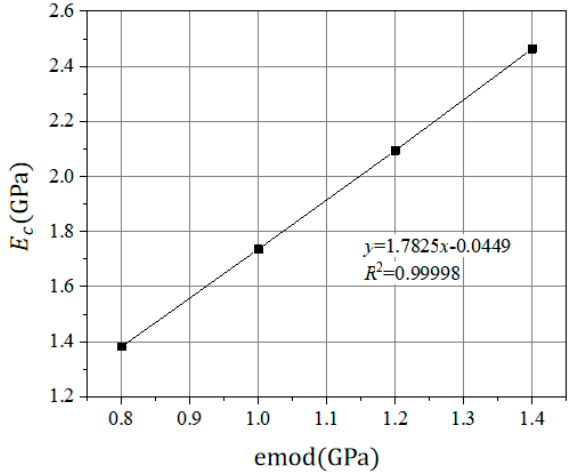
Figure 14. Correspondence between the linear contact modulus and elastic modulus.